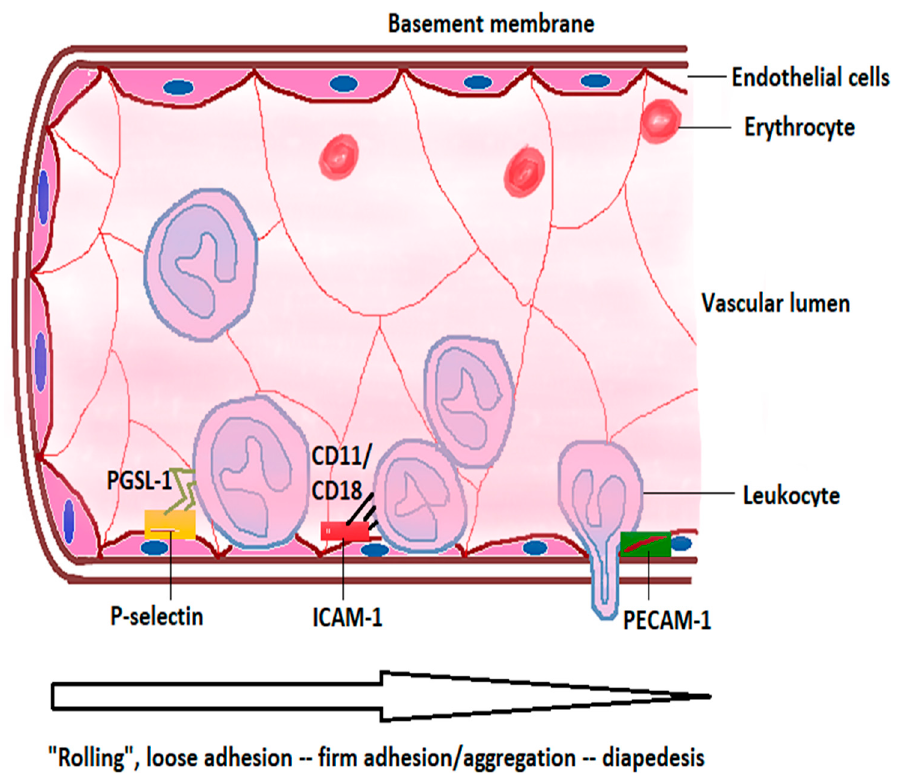
Figure 1. Leukocyte diapedesis. Leukocytes interact with endothelial cells expressing P-selectins through P-selectin glycoprotein 1 (PSGL-1), leading to their “rolling” on the endothelial surface. Interaction of leukocyte integrins CD11a/CD18 and CD11b/CD18 with intercellular adhesion molecule 1 (ICAM-1) leads to firm adherence and aggregation of leukocytes. Diapedesis of leukocytes is facilitated by the expression of platelet endothelial cell adhesion molecule 1 (PECAM-1) by endothelial cells. Adapted from Collard and Gelman [96].